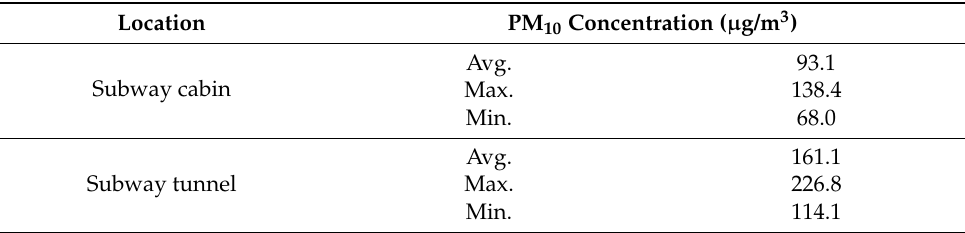
Table 1. PM 10 concentration measurements in subway cabins and tunnels of Seoul Metro Line 5 during non-rush hours (adapted from Jeong et al.